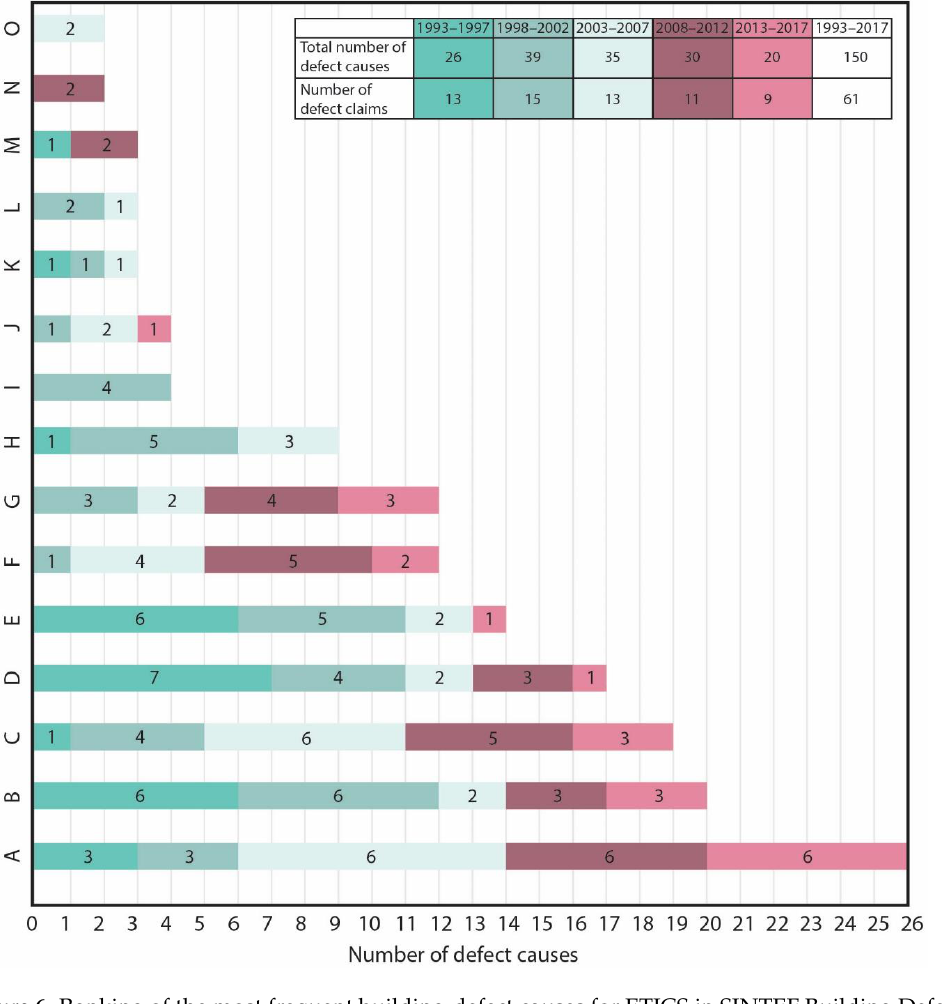
Figure 6. Ranking of the most frequent building-defect causes for ETICS in SINTEF Building Defect Archive (period 1993 – 2017). See description of defect causes A – O in the text.